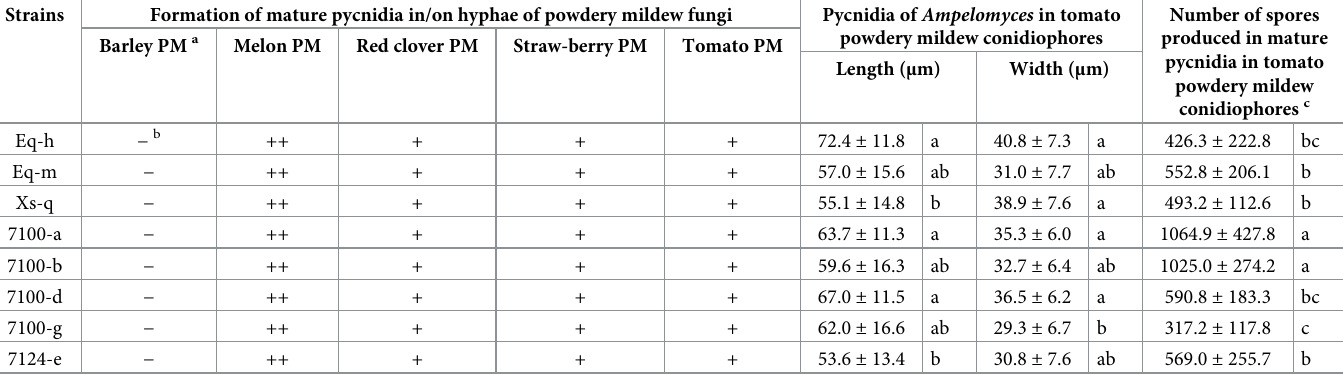
Table 3. Results of the mycoparasitic tests with eight Ampelomyces strains and five powdery mildew species, and morphological characteristics of pycnidia pro- duced in conidiophores of tomato powdery mildew KTP-03.